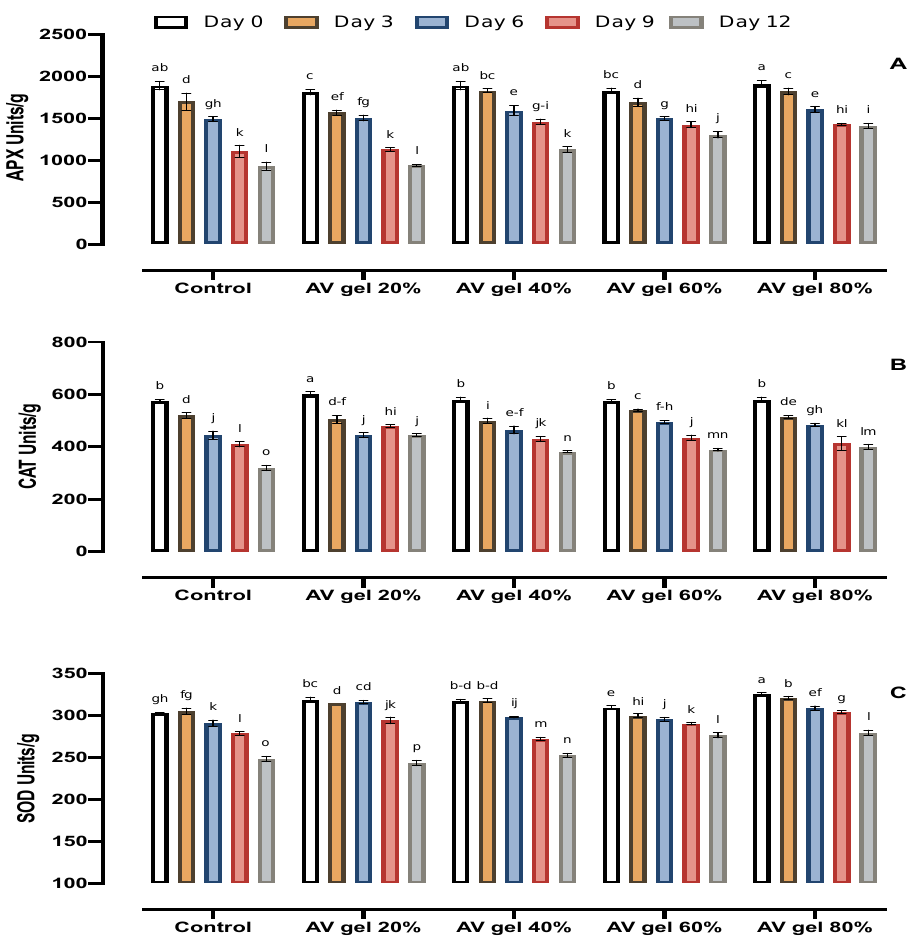
Figure 7. Effects of AV gel coating on ascorbate peroxidase (APX) ( A ), catalase (CAT) ( B ), and superoxide dismutase (SOD) ( C ) in guava fruit. Standard error shown by vertical bars; each value is the mean of three replicates. Di ff erent letters on the top of the bars indicate significant di ff erences ( p ≤